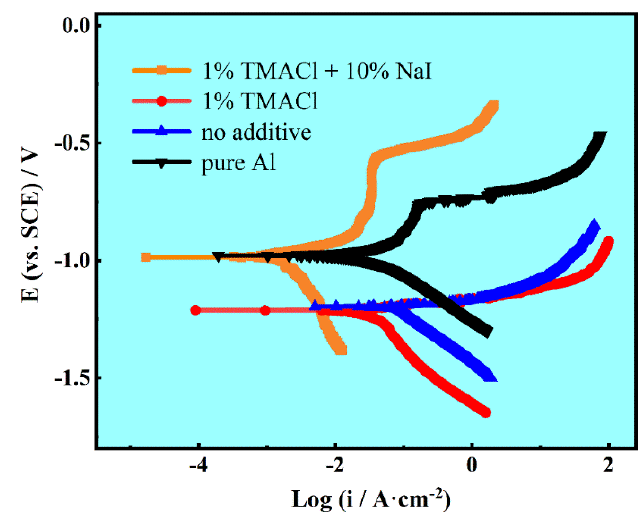
Figure 9. The potentiodynamic polarization curves of pure Al, Al coating electrodeposited without additive, with 1% TMACl and with 1% TMACl + 10% NaI.